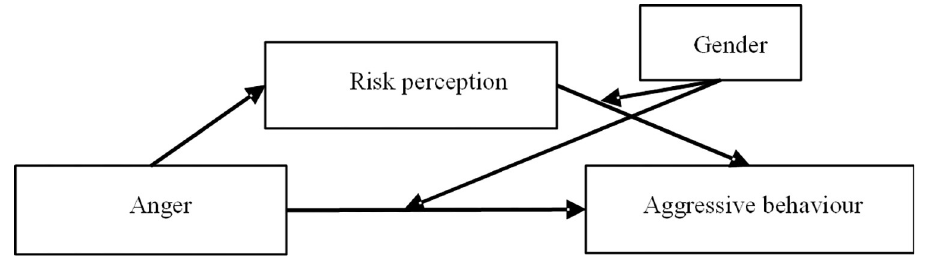
Fig 4. Model d: The effect of anger on aggressive driving